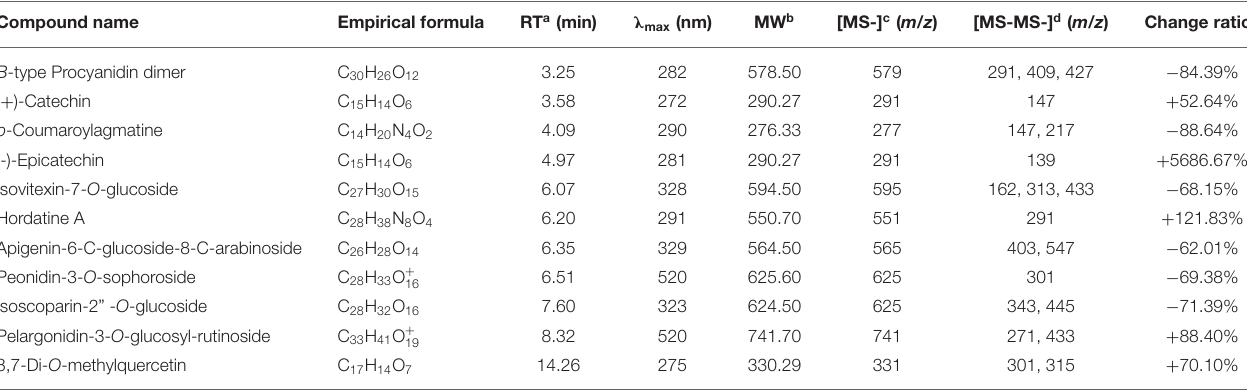
TABLE 1 | Identification of phenolic compounds in the unfermented and fermented barleys using the spectral characteristic in UPLC and ion fragment information in